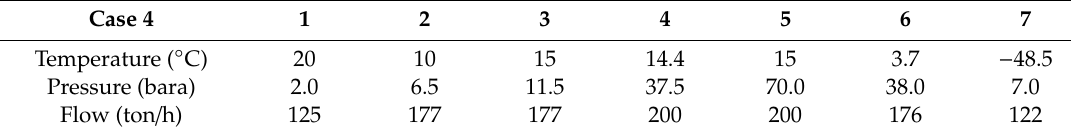
Table A4. Mass balance for the Case 4 verification model, numbering as Figure 1d.